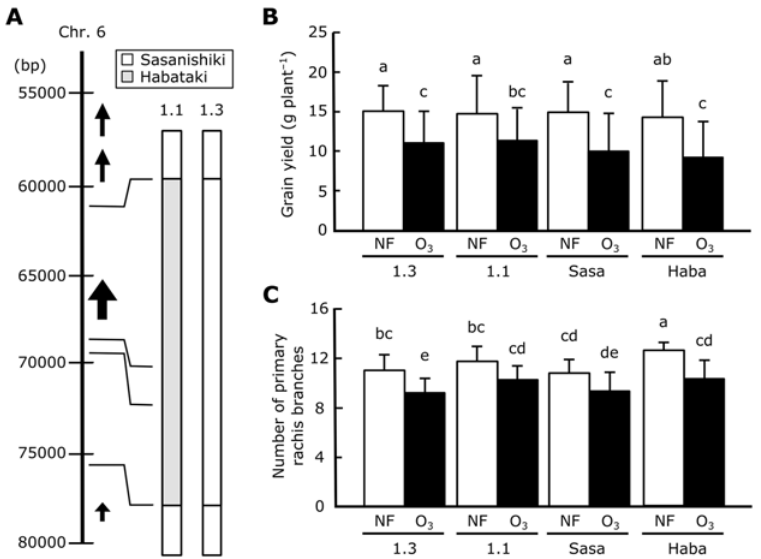
Fig 4. Effects of the Habataki-type APO1 gene in Habataki and the SHA422-1.1 near-isogenic line. (A) Graphical genotype of chromosome 6 of SHA422-1.1 ( APO1 near-isogenic line) and SHA422-1.3. The thickest arrow represents the open reading frame of APO1 ; narrower arrows represent other predicted genes. 1.1, SHA422-1.1; 1.3, SHA422-1.3. Modified from [20]. (B, C) Effects of the Habataki-type APO1 gene on (B) grain yield and (C) the number of primary rachis branches. Values are mean ± SD ( n = 36). NF, non-filtered air (converted values); O 3 , elevated ozone. Bars topped by the same letters are not significantly different (Tukey ’ s HSD test, P < 0.05).